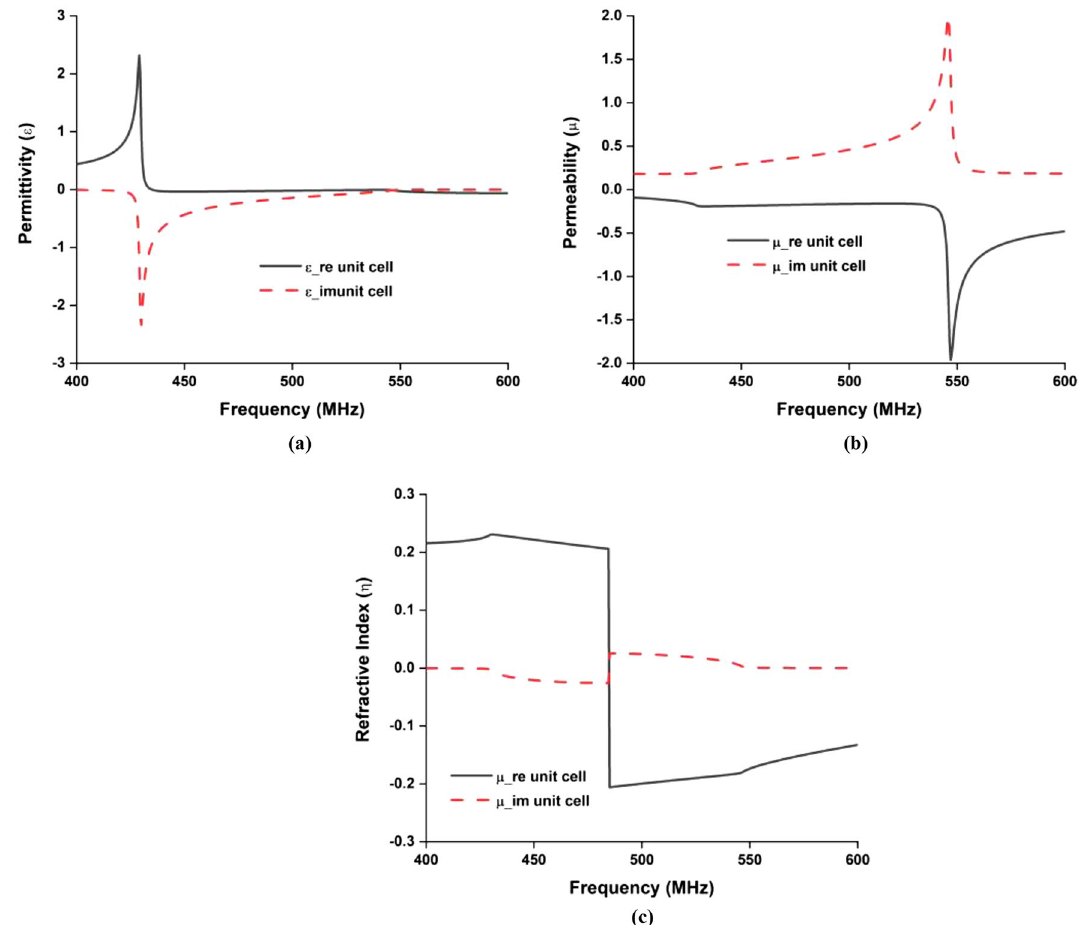
Figure 4. Retrieved metamaterial characteristics for the metamaterial unit cell ( a ) permittivity, ( b ) permeability, and ( c ) refractive